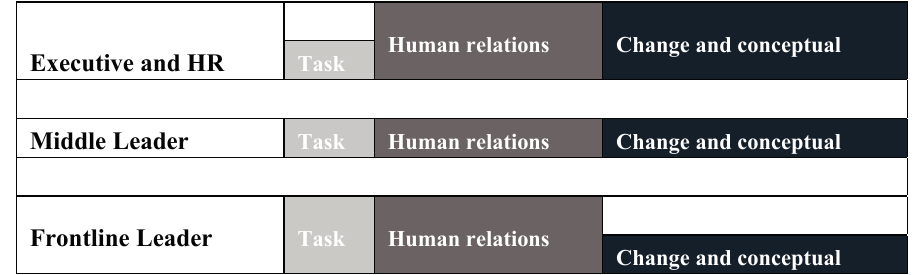
Figure 2. Three domains of leadership; Source: Katz [41] cited in Northouse